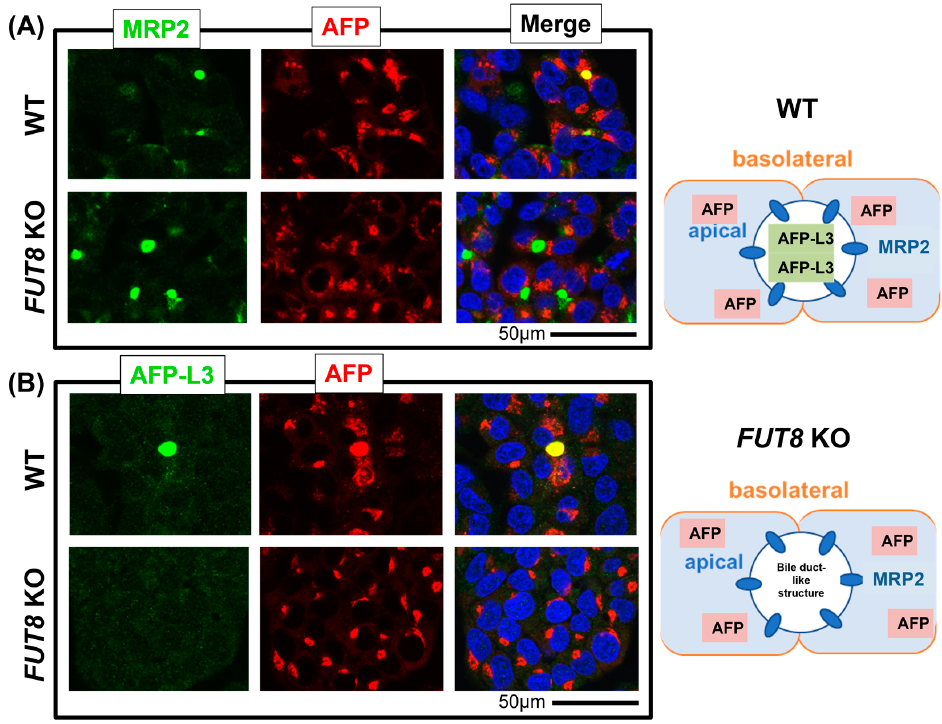
Figure 1. Localization of AFP-L3 was observed in the bile duct-like structures in WT HepG2 cells. ( A ) WT and FUT8 -KO HepG2 cells were co-stained with anti-MRP2 (green) and anti-AFP (red) antibodies. ( B ) WT and FUT8 -KO HepG2 cells were co-stained with anti-AFP-L3 (green) and anti-AFP (red) antibodies. Colocalization is displayed in yellow (Merge). Blue is the nuclear stain using 4 ′ ,6-diamidino-2-phenylindole (DAPI). The cellular localization of AFP and AFP-L3 is shown in the schematic diagram.